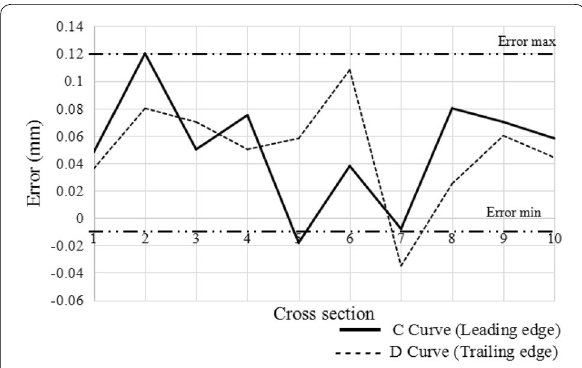
Figure 24 Error of C and D curves